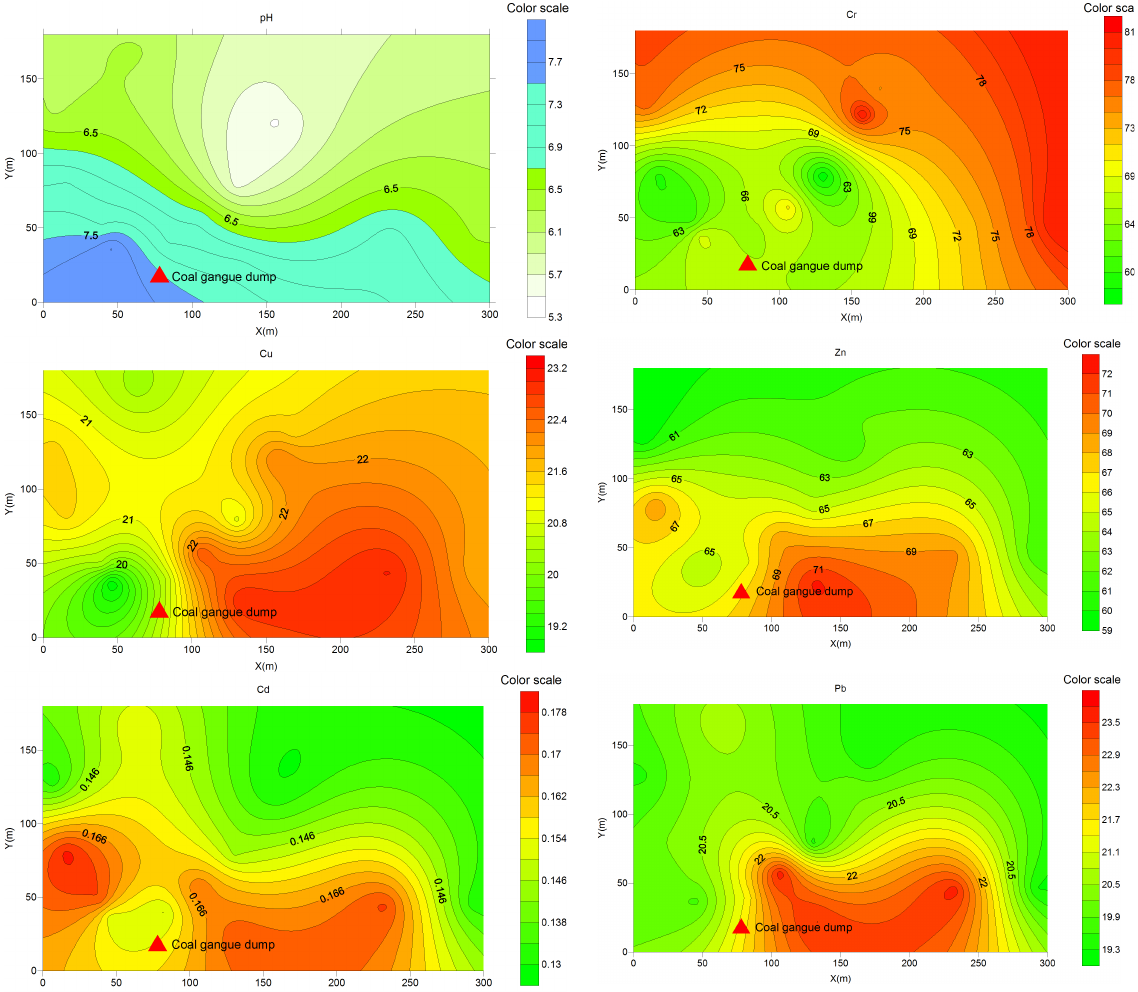
Figure 2. The contour maps of pH, Cr, Cu, Zn, Cd and Pb in the topsoil around the coal gangue dump (the red triangle represents the coal gangue dump).